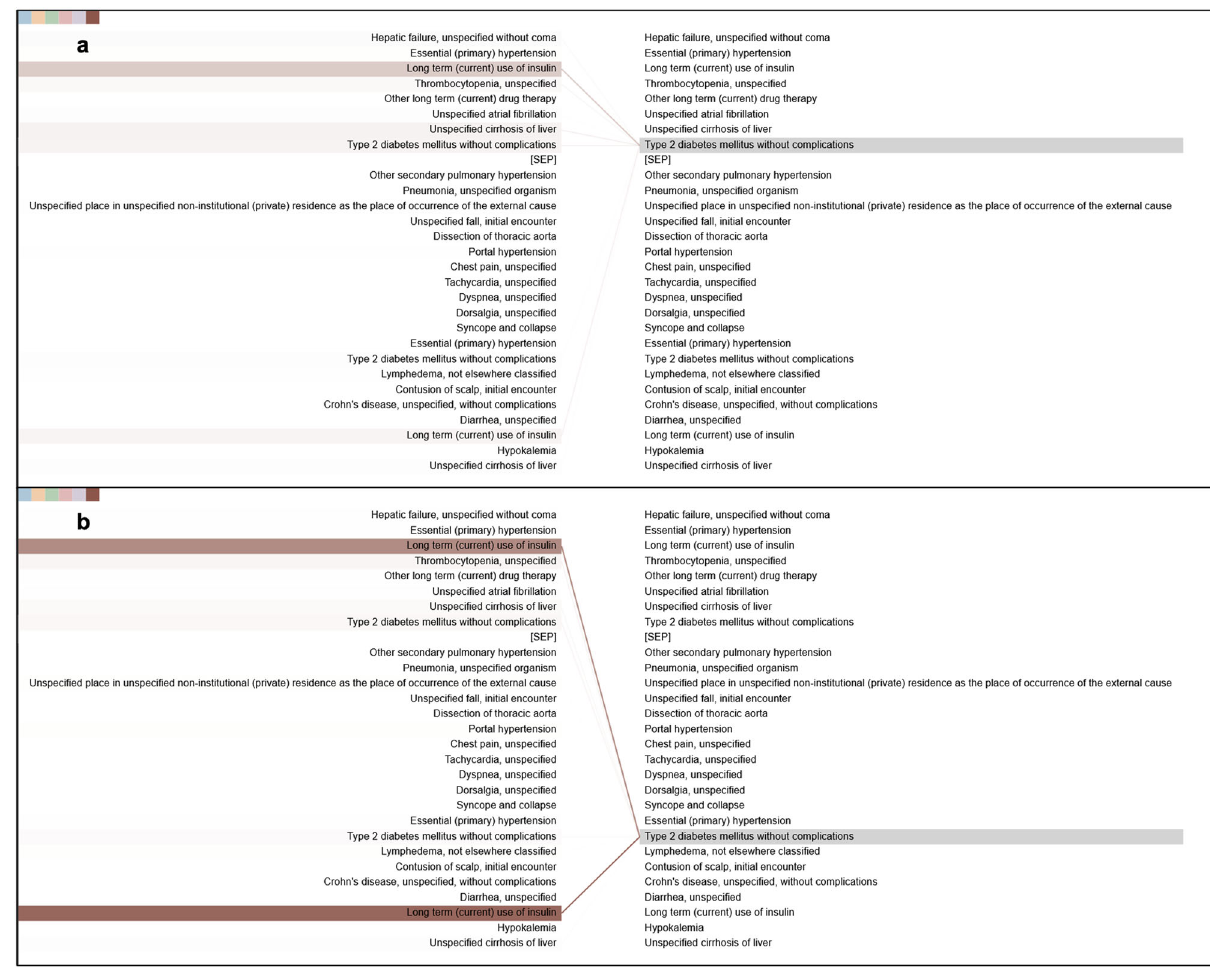
Fig. 5 Example of different connections of the same code, “ type 2 diabetes mellitus ” , in different visits. a The fi rst visit, b the second visit. Connection lines from the code in the left panel to the code in the right panel indicate attentions of the Med-BERT model. Color of the line indicates individual attention head, and intensity of the line indicates attention